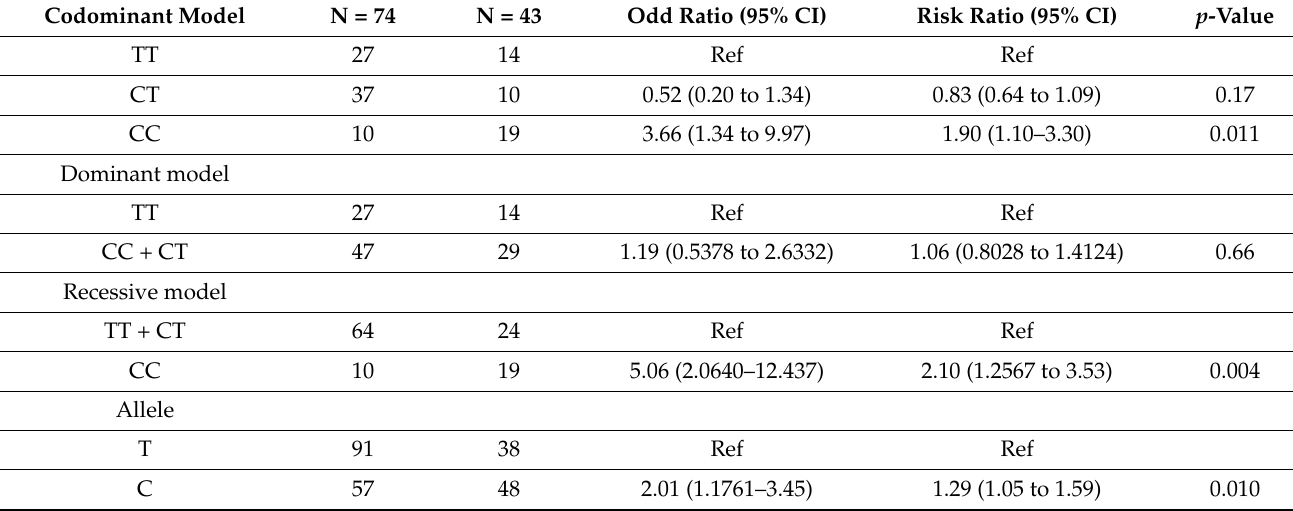
Table 11. Statistical comparisons ( p -values) of ACE2 rs4240157 T > C genotypes with mortality of COVID-19 patients. Codominant